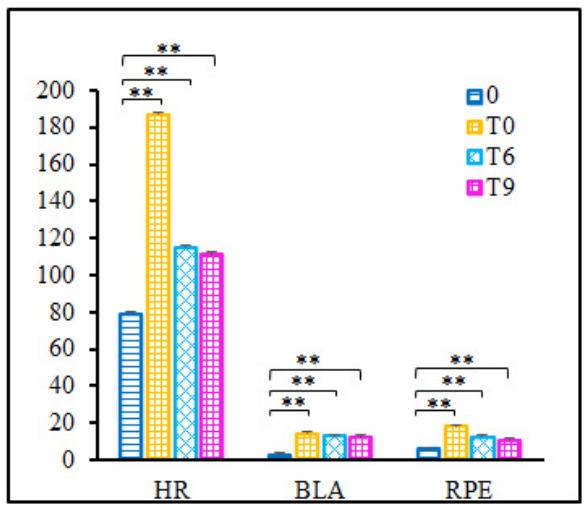
Figure 3. Rate of heart (HR) (beats per minute, bpm), blood lactate (BLA) (mmol/L) and Borg 6–20 rating of perceived exertion (RPE). 0—baseline, before fatigue protocol; T0—immediately after fatigue protocol; T6—the 6th minute after fatigue protocol; T9—the 9th minute after fatigue protocol. Note: ** indicates the significance level p < 0.001.